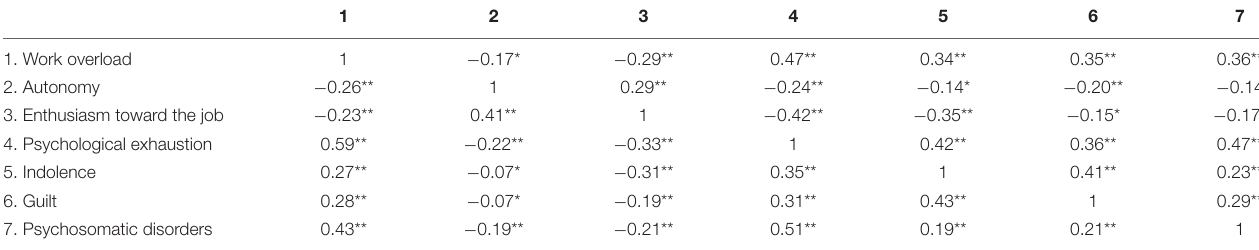
TABLE 2 | Correlations between variables of the study.